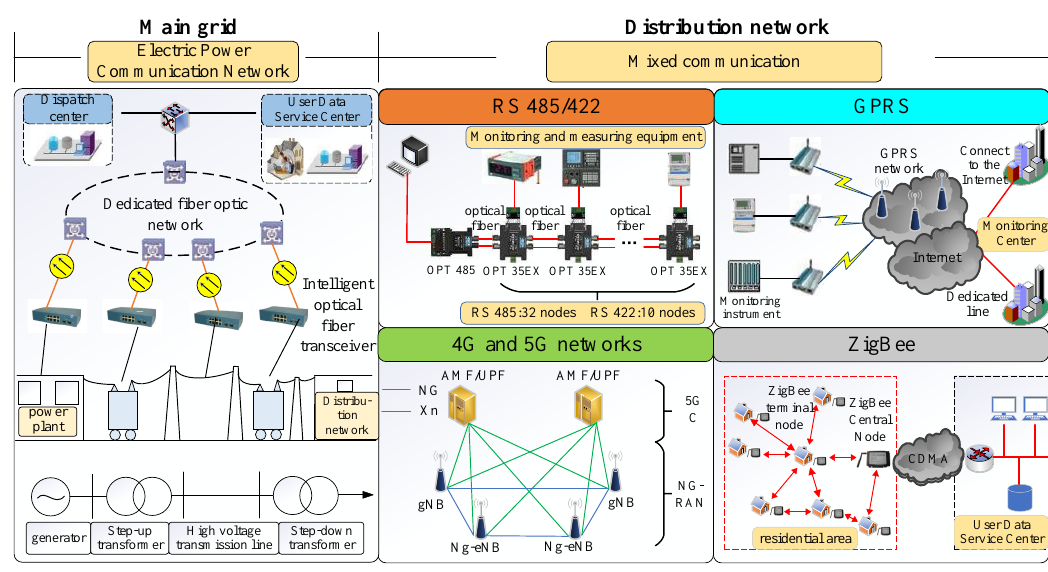
Figure 2. Main grid and distribution network.